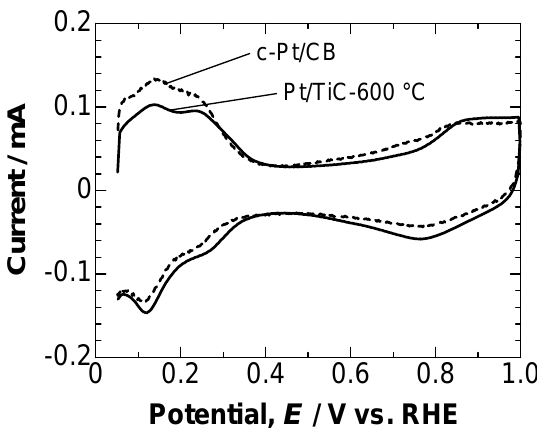
Figure 4. Cyclic voltammograms for Pt/TiC-600 °C and c-Pt/CB in N 2 -saturated 0.1 M HClO 4 at a sweep rate of 0.1 V s − 1 .